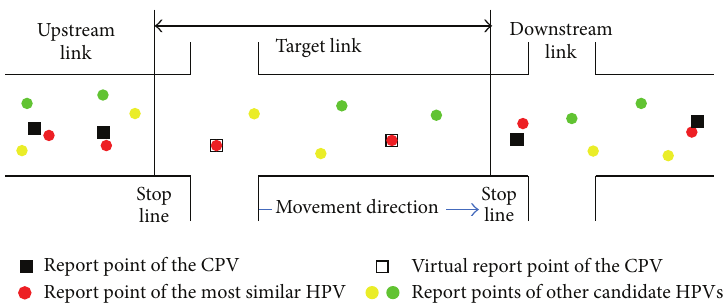
Figure 1: Schematic of the virtual report point creation